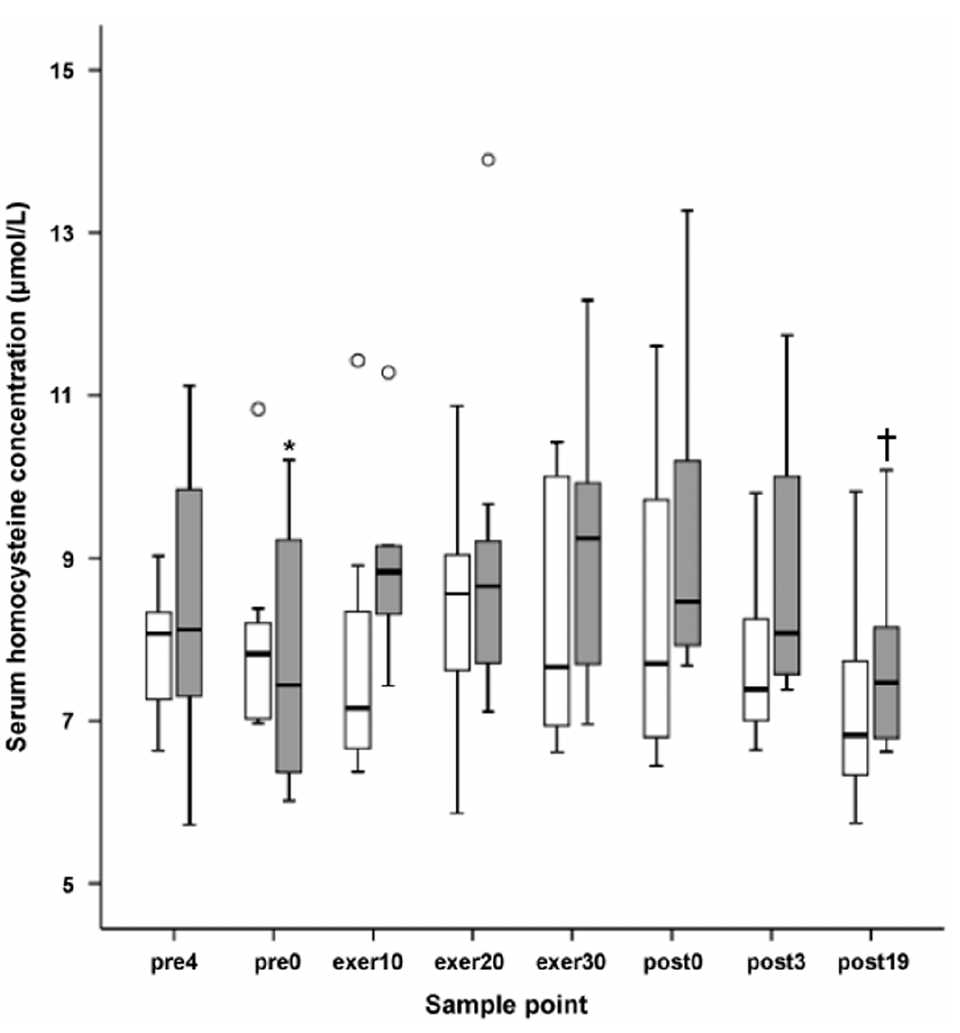
Figure 2. Distribution of serum homocysteine concentration values in every sampling point at low and high intensity isocaloric exercise trials. Open bars, Low intensity exercise (40% VO 2peak ); Grey bars, High intensity exercise (80% VO 2peak ). Open dots represent outliers. *Significant differences in high intensity exercise ( P , 0.05) between pre0 vs. exer10, exer20, exer30, and post0. { Significant differences in high intensity exercise ( P , 0.05) between post19 vs. exer10, 20, 30, post0, and post 3. pre4: Blood sample 4 h before exercise; pre0: Blood sample immediately before exercise; exer10: Blood sample 10 min during exercise; exer20: Blood sample 20 min during exercise; exer30: Blood sample 30 min during exercise; exer45: Blood sample 45 min during exercise; exer60: Blood sample 60 min during exercise; post0: Blood sample immediately after exercise; post3: Blood sample 3 h after exercise; post19: Blood sample 19 h after exercise.